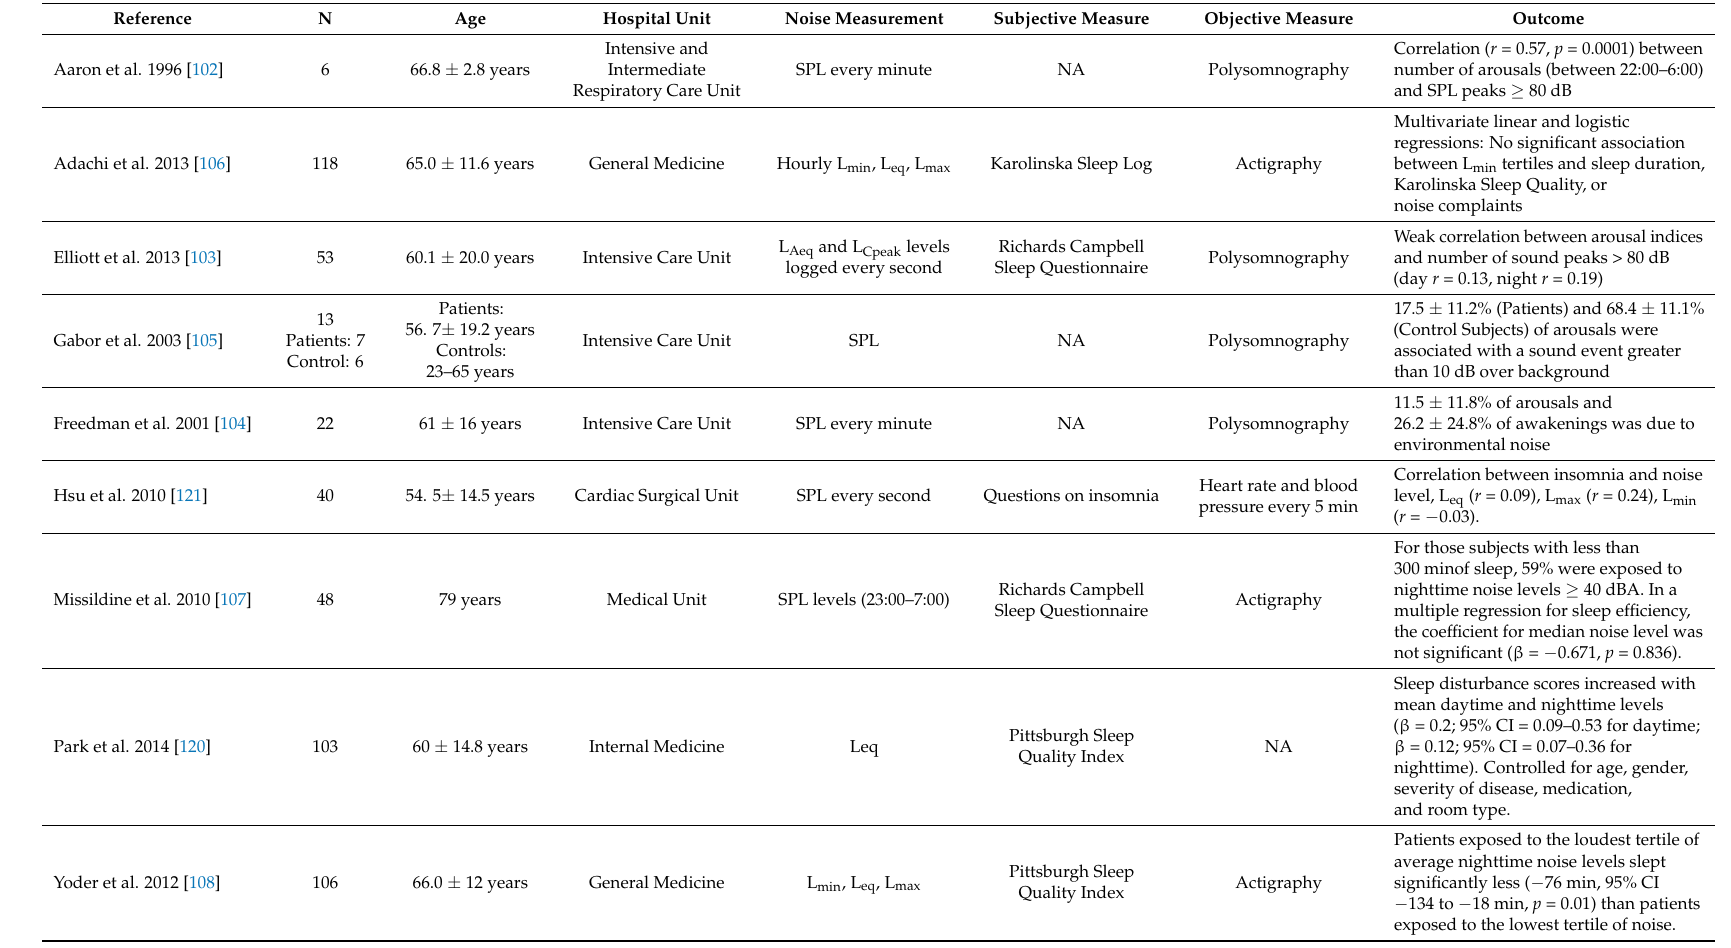
Table 8. Characteristics of studies on hospital noise and sleep in